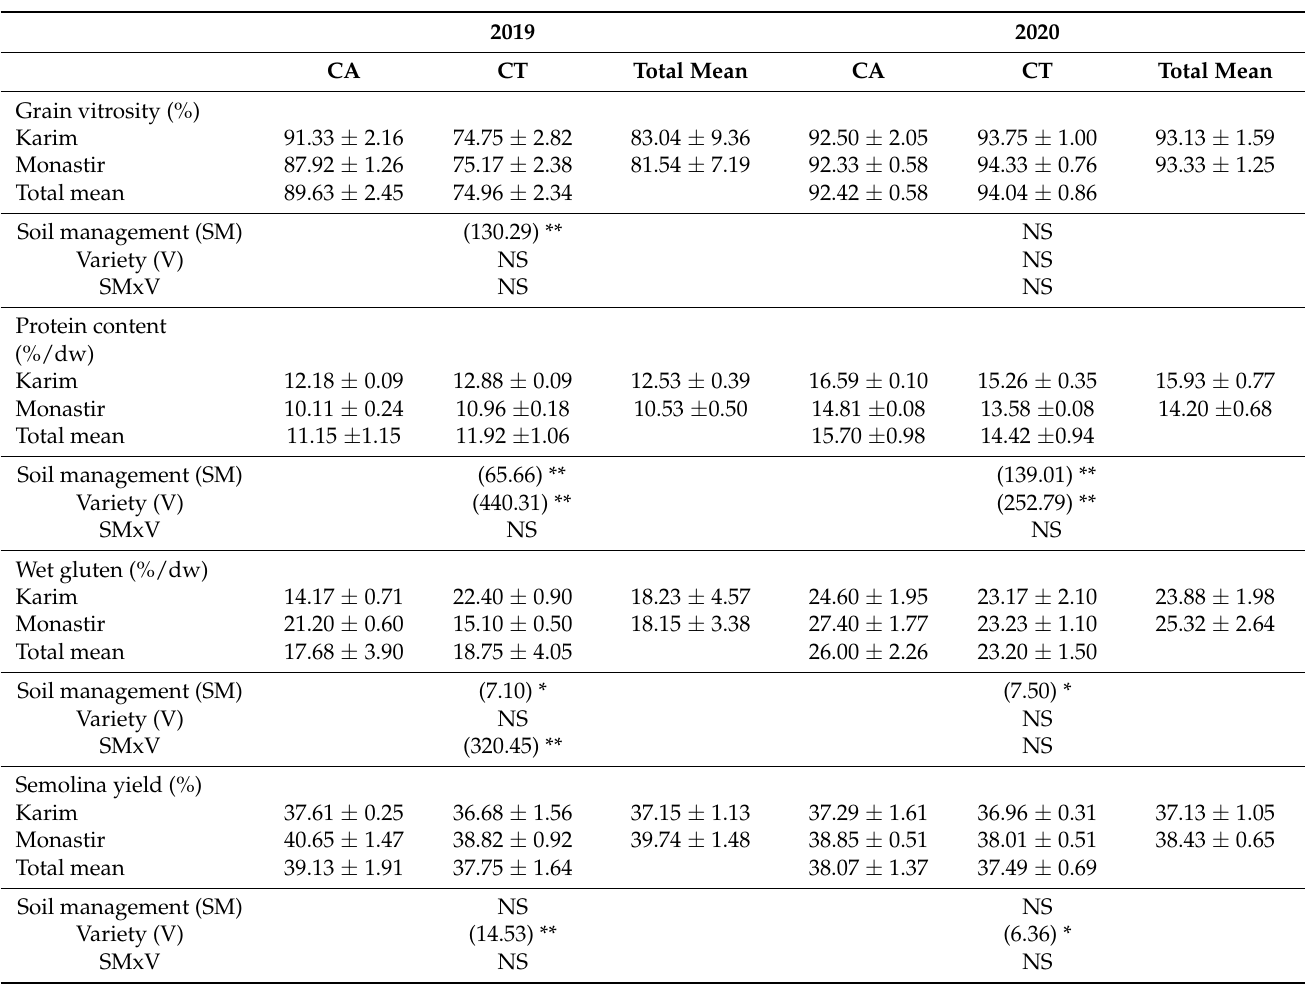
Table 2. Grain quality and semolina yield of two durum wheat varieties under two soil management systems (SM) grown over two cropping